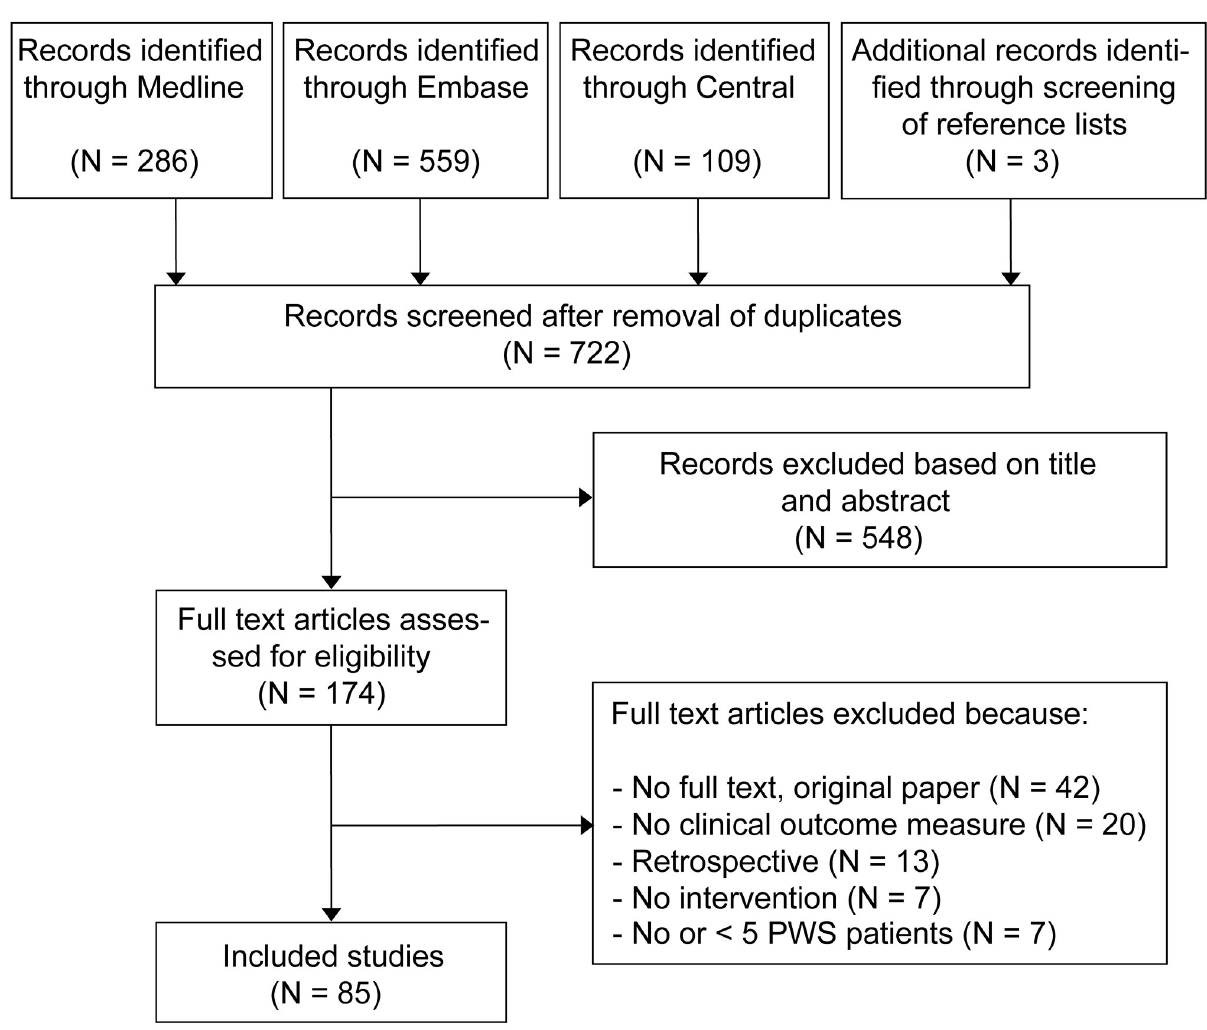
Fig 1. PRISMA flow diagram showing the study selection and exclusion process. In total, 85 prospective studies with a clinical outcome measure published since 2005 were included. Abbreviations: PWS , port wine stain.